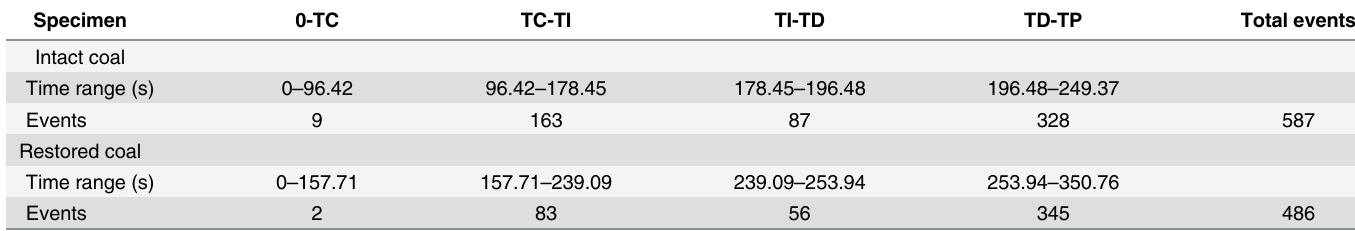
Table 5. Specific parameters for damage source locations based on AE